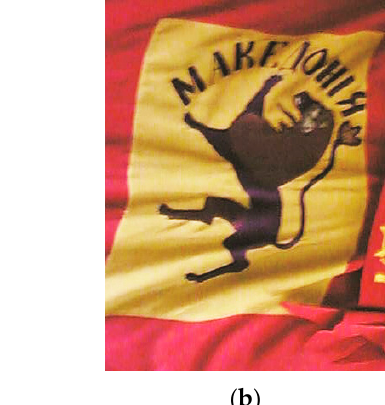
Figure 12. ( a ) Monastery of St. Ivan of Rila; ( b ) Flag of the Razlovci Uprising of 1876.